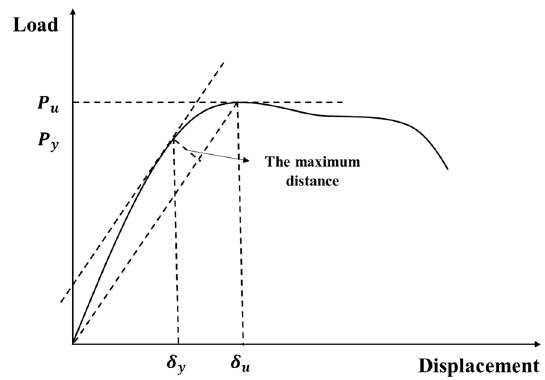
Figure 15. Determination of the yield strength.